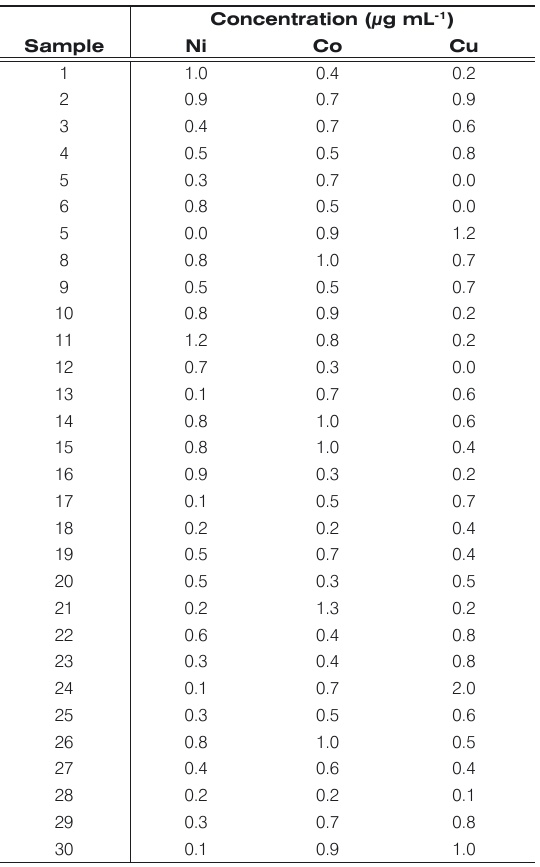
Table 2. Values of the Cu(II), Co(II) and Ni(II) concentrations (μg mL -1 ) used as calibration solutions (randomly